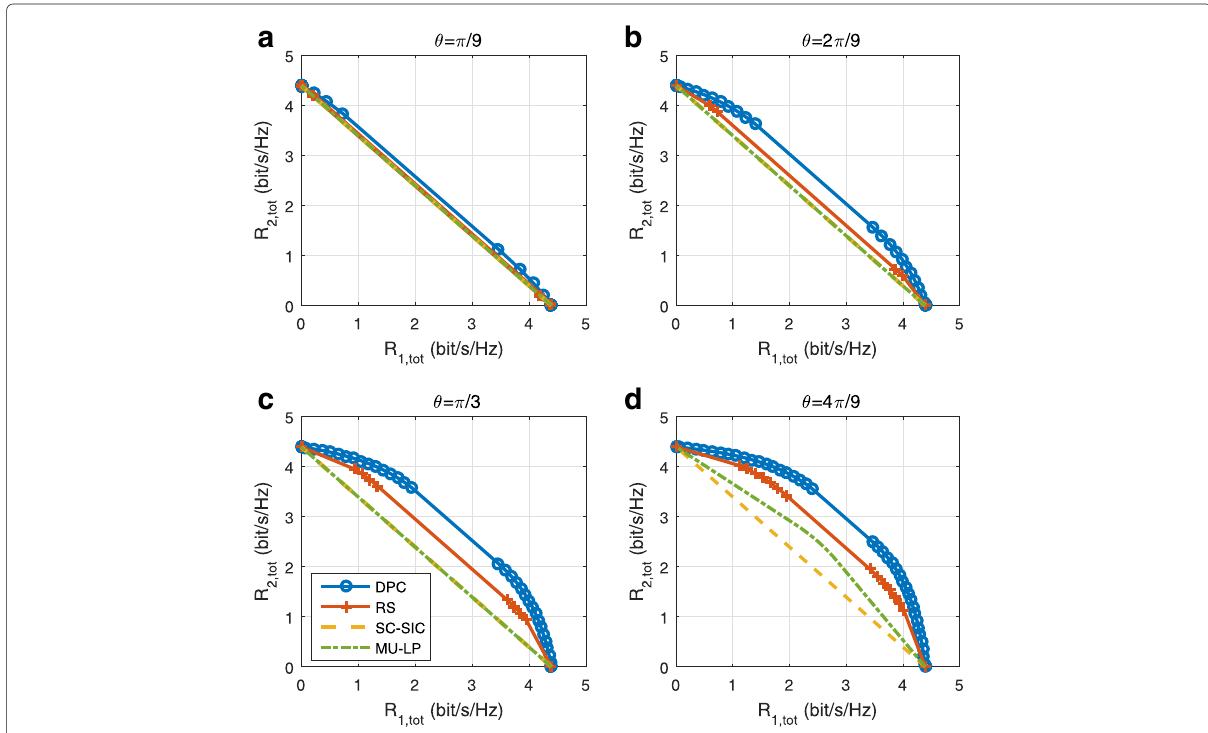
Fig. 23 Achievable rate region comparison of different strategies in underloaded two-user deployment with perfect CSIT, γ = 1, N t = 2,